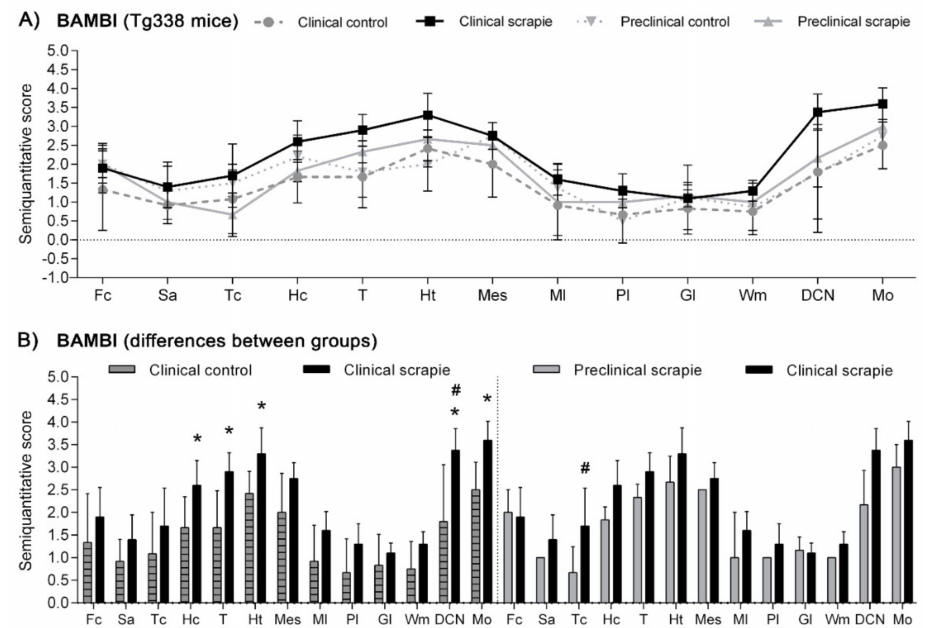
Figure 5. Semi-quantitative scoring of BAMBI in the central nervous system of scrapie-infected Tg338 mice. Figure includes a global graph ( A ) and comparative graphs ( B ) between clinical group (black bars) with preclinical (grey bars) and control group (grey-striped bars). Comparative graphs between the preclinical group and their control group, and between control groups, are not shown because no significant di ff erences were detected. Score values (from 0: negative, to 5: staining present at its maximum intensity) evaluated in the frontal cortex (Fc), septal area (Sa), thalamic cortex (Tc), hippocampus (Hc), thalamus (T), hypothalamus (Ht), mesencephalon (Mes), cerebellum (which includes molecular layer (Ml), Purkinje layer (Pl), granular layer (Gl), white matter (Wm) and deep cerebellar nuclei (DCN)) and medulla oblongata (Mo). The di ff erences between the experimental groups were determined using the Mann Whitney U test (* p < 0.05). Significant di ff erences after Bonferroni correction for multiple tests are shown as # p <